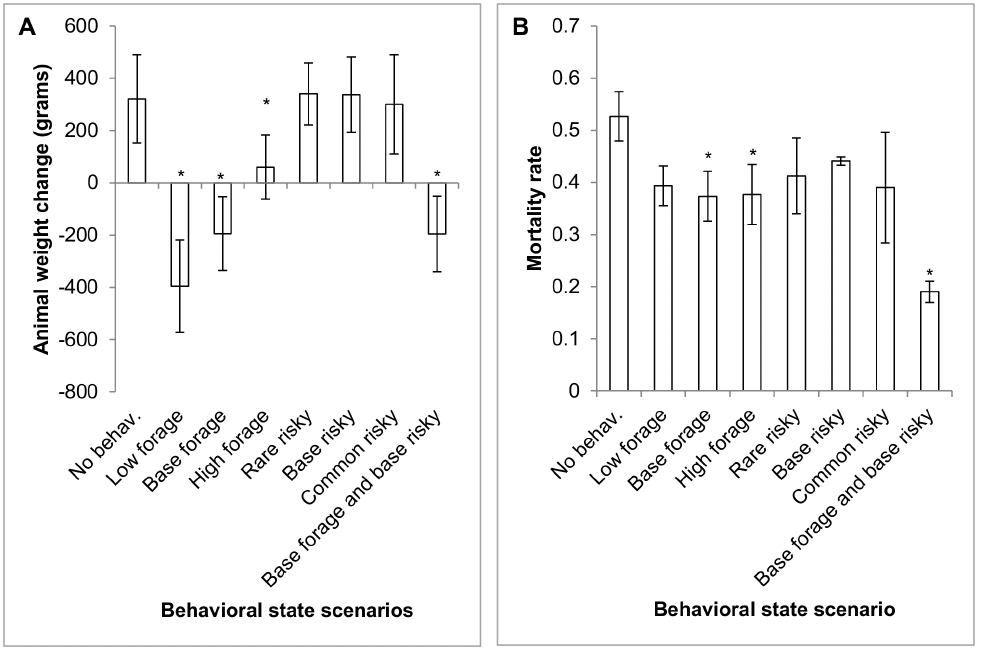
Figure 3. Effect of behavioral state switching on American martens. Mean ( 6 1 SD) marten A) weight change (pooled for all replicates) and B) mortality rate for eight behavioral state scenarios (three replicates per scenario). Simulations consisted of animals with no behavioral state changes (no behav.), a search-forage threshold of 4000 (low forage), a search-forage threshold of 4250 (base forage), a search-forage threshold of 4500 (high forage), a risky-safe proability of 0.001 (rare risky), a risky-safe probability of 0.01 (base risky), a risky-safe probability of 0.1 (common risky) or a search- forage threshold of 4250 and a safe-risky probability of 0.01 (base forage and base risky). Asterisk denotes scenarios that were significantly different from no behavior simulations.